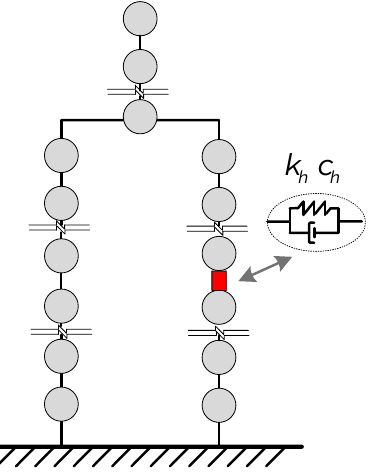
Figure 3. The simplified model of the proposed structure.